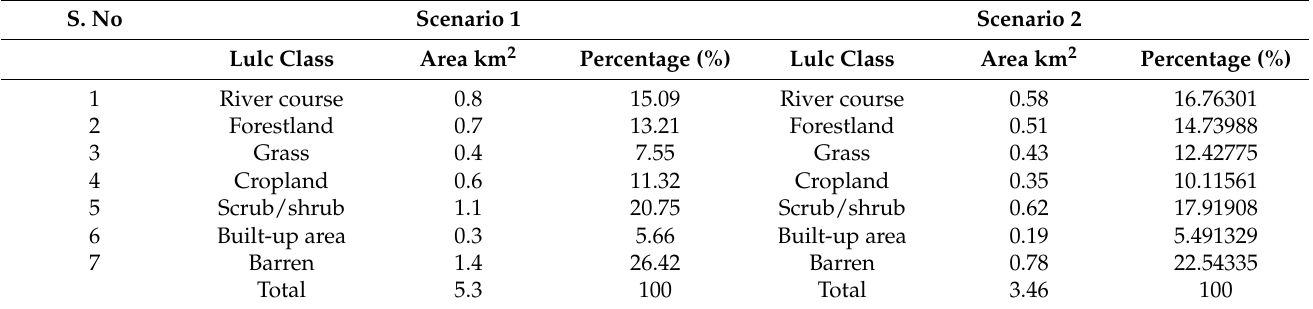
Figure 19. LULC maps generated for GLOFs: ( a ) scenario 1 and ( b ) scenario 2. Table 7. The inundated area under different LULC classes in scenario 1 and scenario